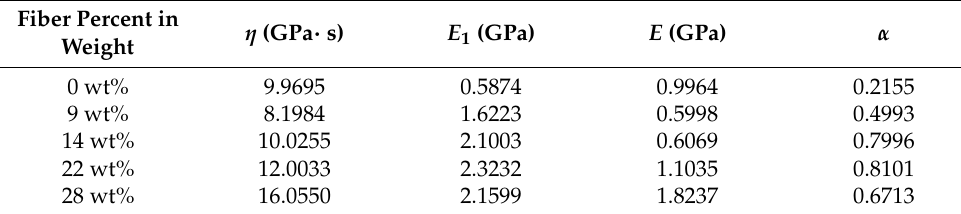
Table 2. Parameters of the Zener fractional index